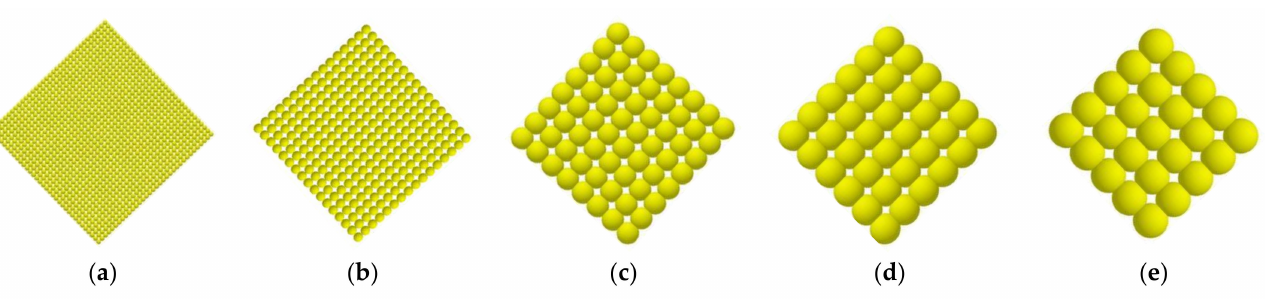
Figure 5. Construction of sugarcane leaf simulation model; ( a ) r = 0.5 mm, ( b ) r = 1.0 mm, ( c ) r = 2.0 mm, ( d ) r = 3.0 mm, ( e ) r = 4.0